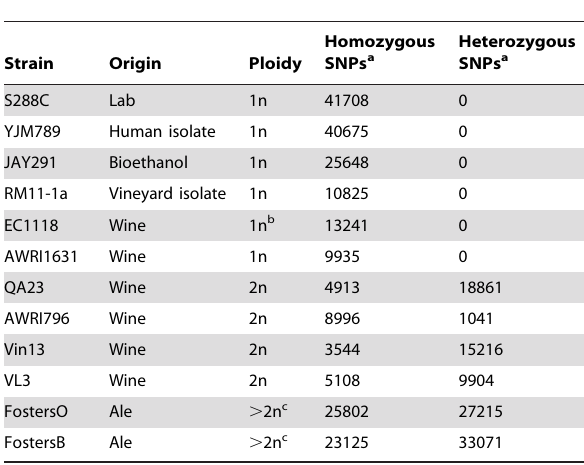
Table 2. Heterozygosity in industrial S. cerevisiae strains.